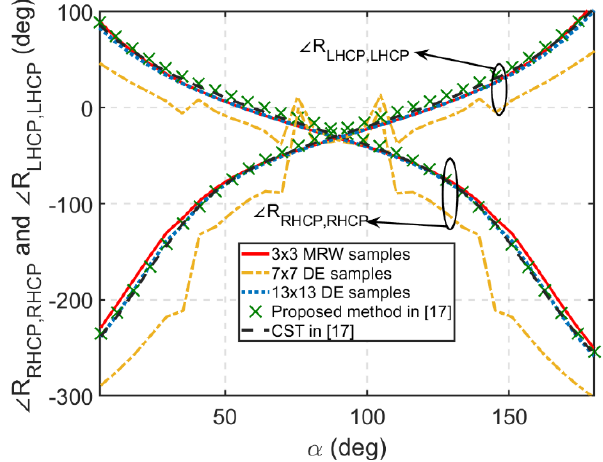
Figure 6. Reproduced results of the phase curves shown at 29.75 GHz in [17] by the integration of (7) and (8), by MRW quadrature, DE quadrature for a different number of samples per region and by CST.